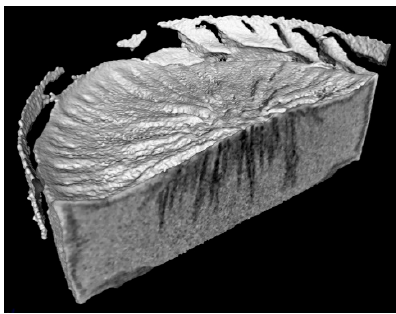
Figure 3. Visualization of the reconstructed three-dimensional (3D) tomography image of the frozen and partially dried maltodextrin sample with vertical cut through the center. The dark fingers penetrating the sample in the center correspond to dry regions.